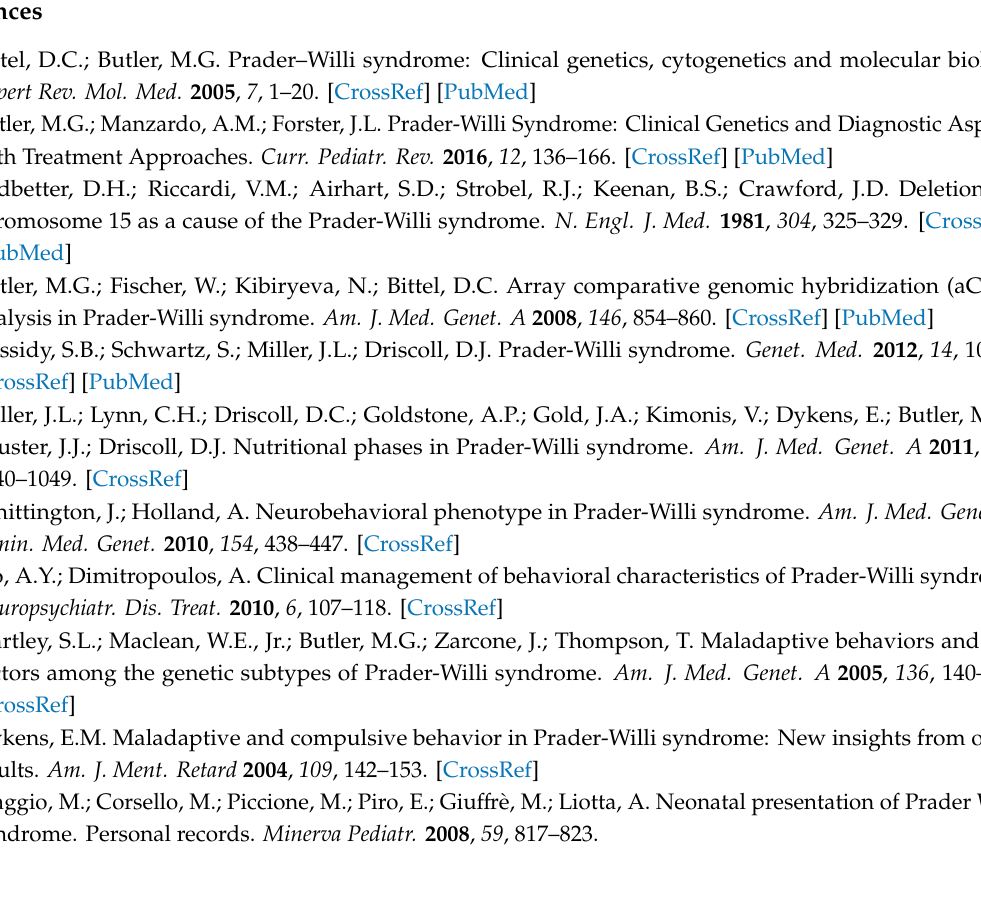
Table S1: Characteristics of Study Participants with 1 versus 2